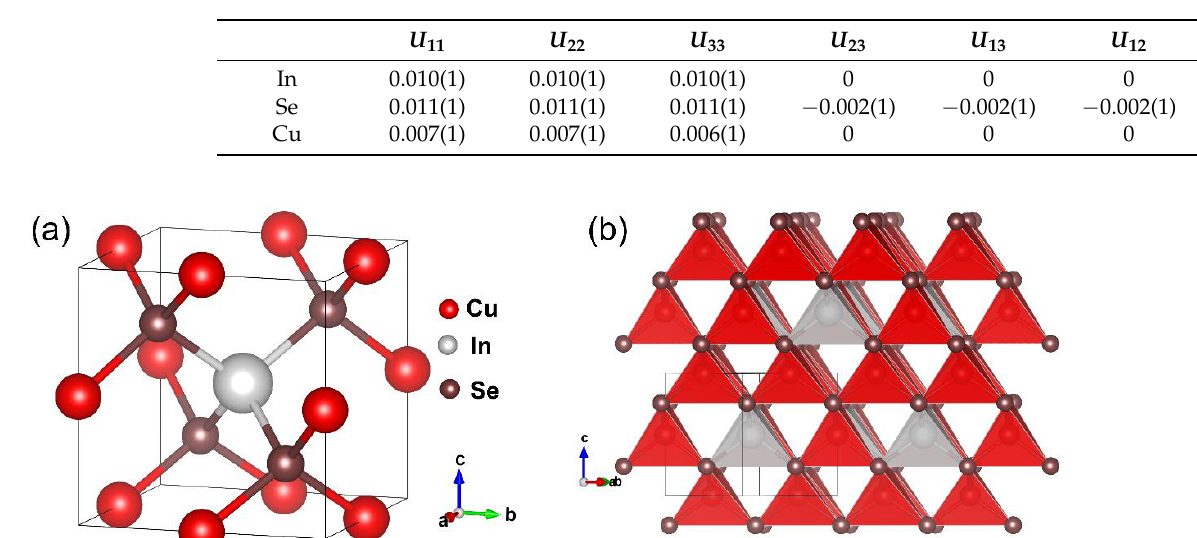
Table 3. Anisotropic displacement parameters (Å 2 ). The anisotropic displacement factor exponent